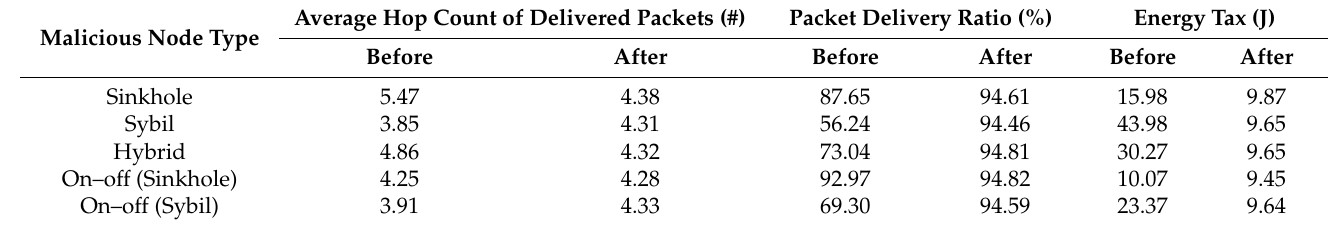
Table 3. Experimental results of 10% of malicious nodes before and after DOIDS